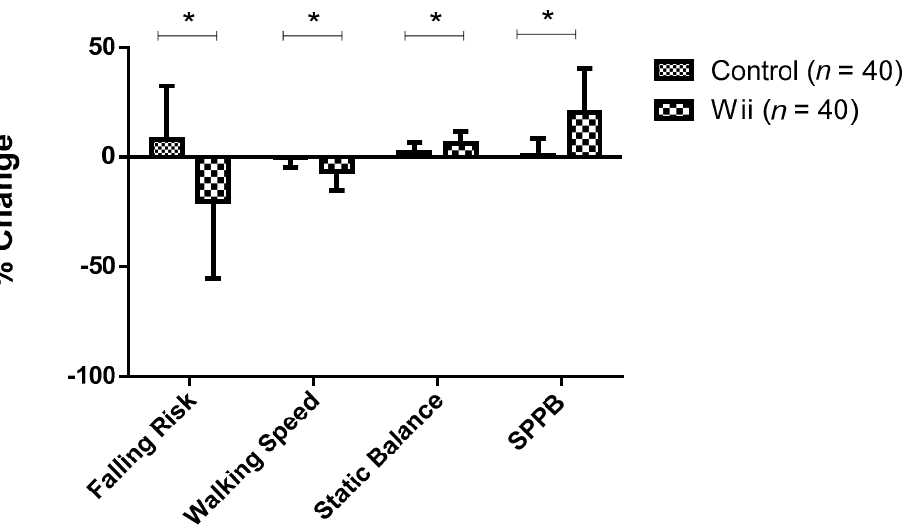
Figure 1. Percentage change for the studied variables in both groups. Data are expressed as mean ± SD. * Significant differences between groups ( p < 0.001). SPPB = Short Physical Performance Battery.